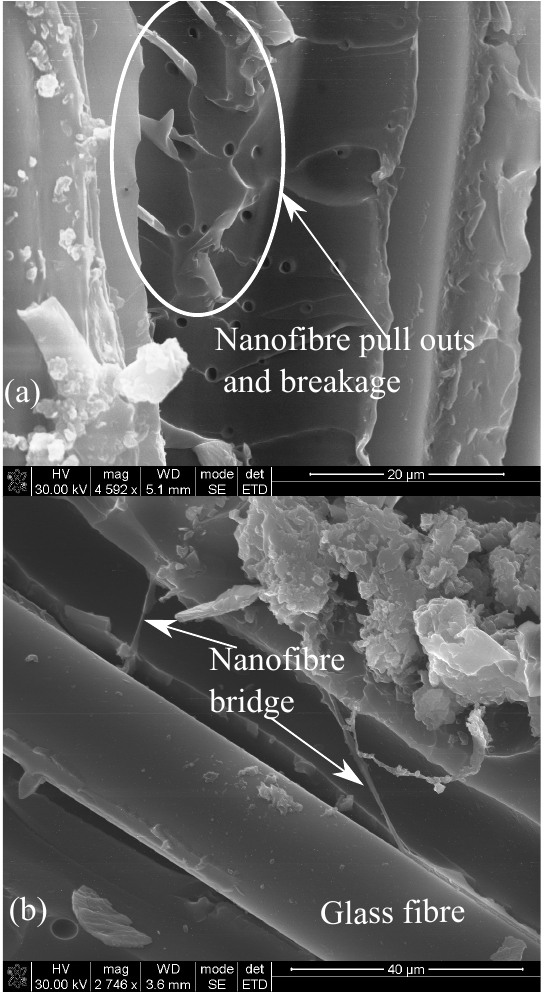
Figure 7. Fracture behavior of 0.5 wt% RONFs mats strengthened hybrid composite ( a ) Pulled out nanofibres ( b ) Bridging of nanofibres.